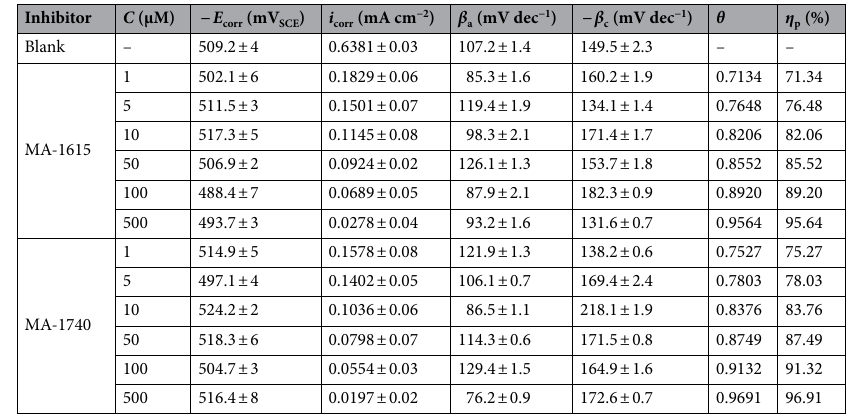
Table 3. Electrochemical kinetic parameters obtained from the polarization measurements on C-steel in uninhibited and inhibited acid solutions with different inhibitors doses at 25 °C.